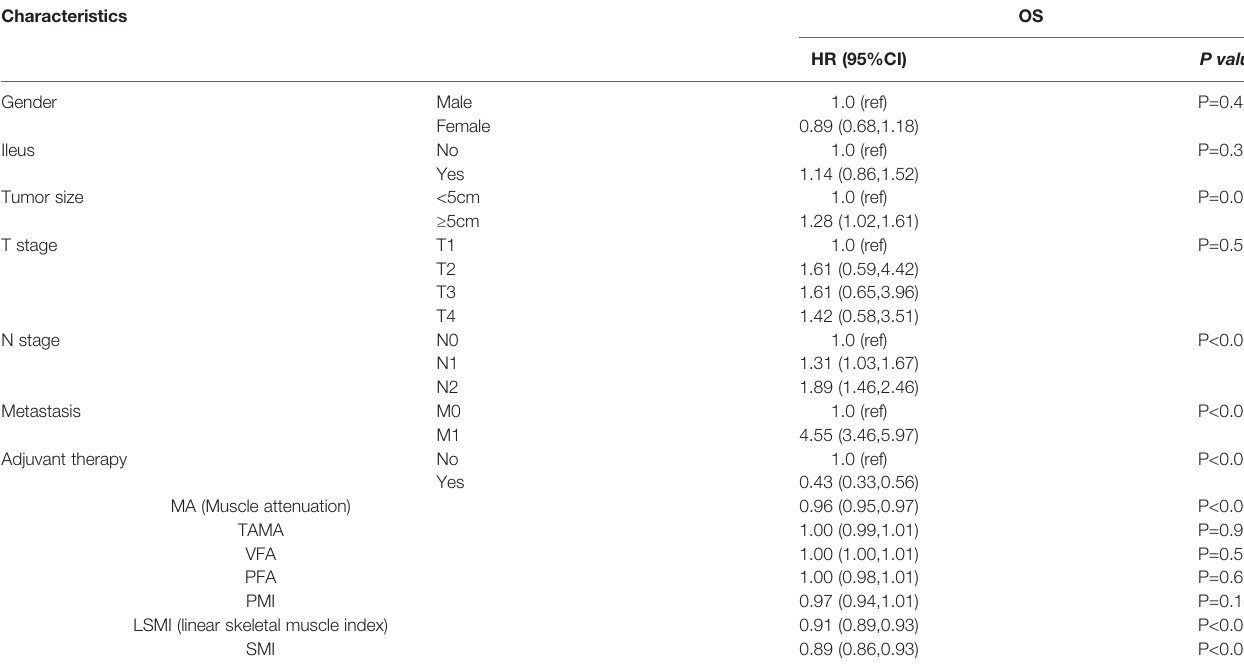
TABLE 3 | Multivariate cox proportional hazard analysis for risk factors of patients ’ prognosis (OS). Characteristics